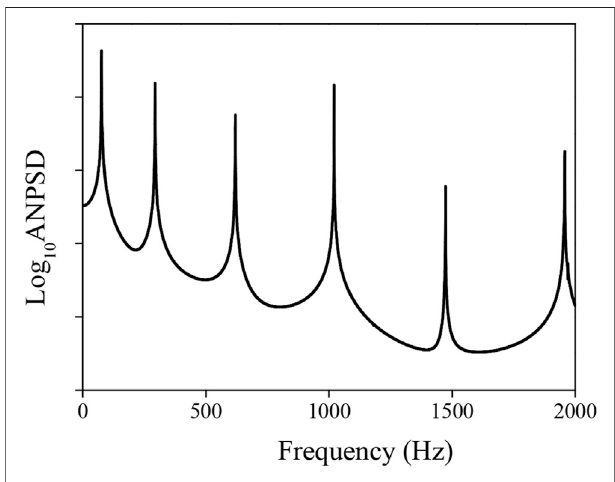
FIGURE 13 | ANPSD of BG1.